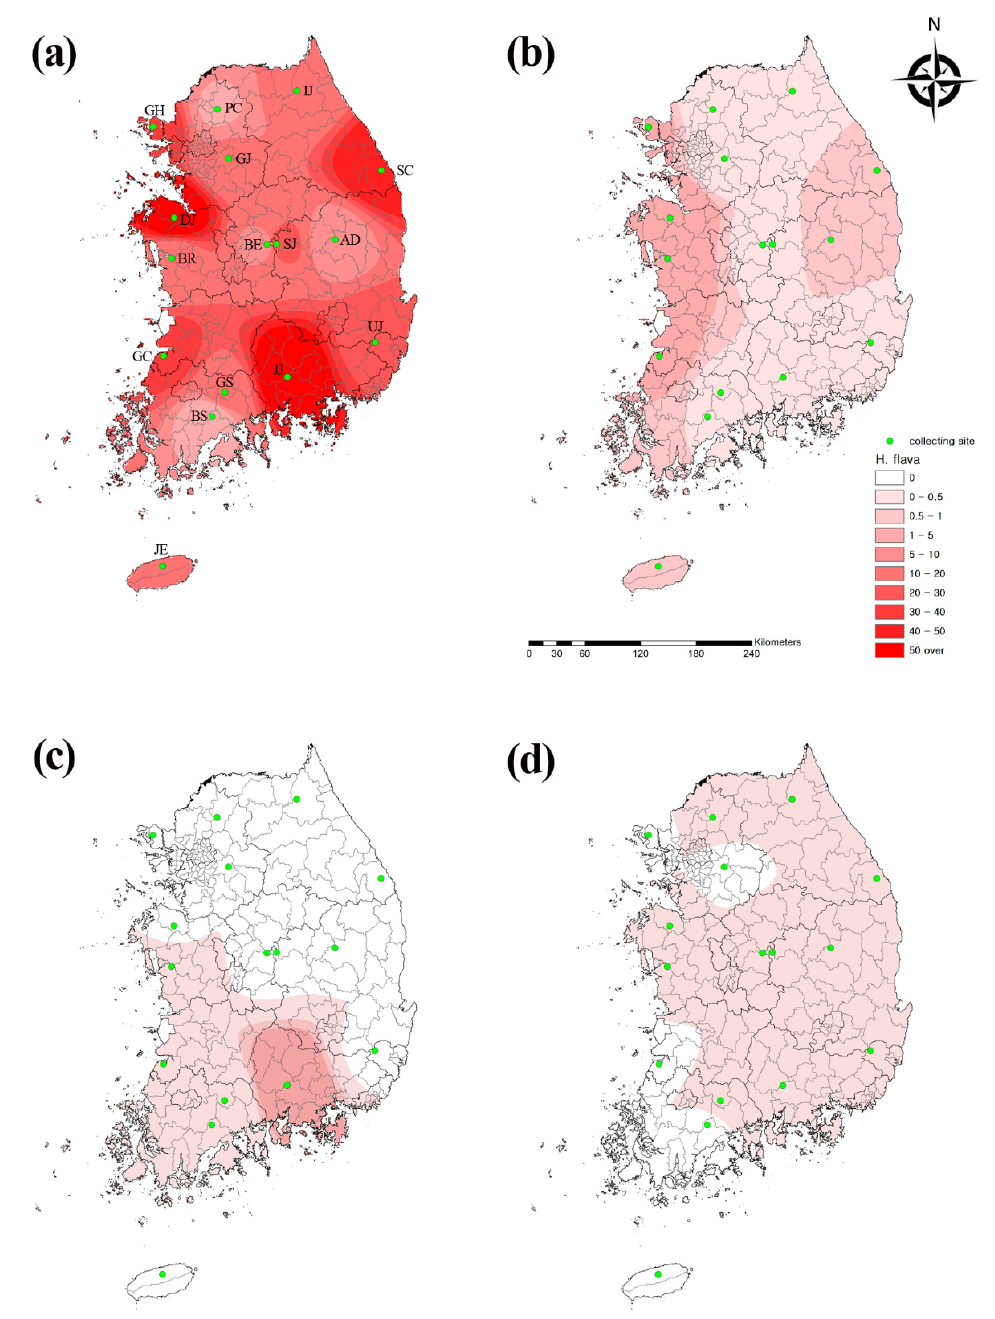
Figure 1. Geographical distribution of four tick species. ( a ) Haemaphysalis longicornis, ( b ) H. flava, ( c ) Amblyomma testudinarium, and ( d ) Ixodes nipponesis collected from traps at 16 collection sites nationwide in Korea in 2020. The map color indicates the trap index (TI; 0 to >50). Collection traps are denoted by green dots. The TI shows the number of ticks per trap. PC, Pocheon; IJ, Inje; GH, Ganghwa; SC, Samcheok; GJ, Gwangju; DJ, Dangjin; BR, Boryeong; BE, Boeun; AD, Andong; SJ, Sangju; GC, Gochang; UJ, Ulju; GS, Gokseong; BS, Boseong; JJ, Jinju, JE, Jeju. In total, 12 dry ice bait-collecting traps (Shin-Young Commerce System, Gyeonggi, Korea) were set up at each point at the collection sites at 10 m intervals (three traps per environmental point). Inside the tarpaulin cylindrical trap (35 cm diameter × 40 cm height), a cylindrical ice chest (10 cm diameter × 30 cm height) containing four pieces of